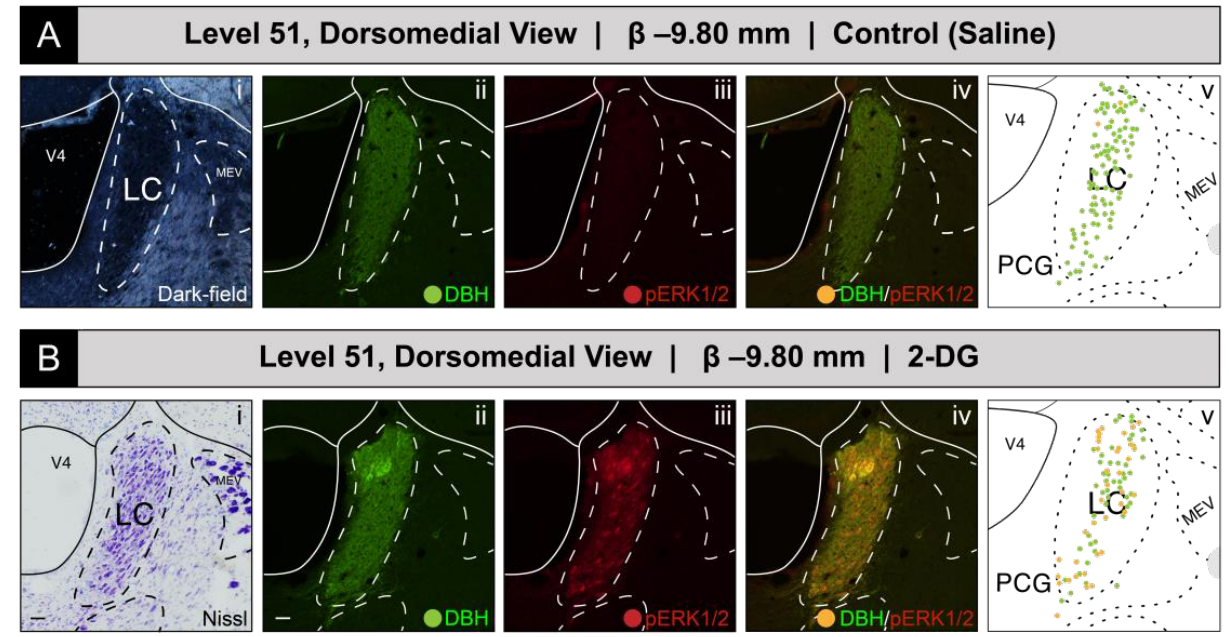
Figure 2. Increased recruitment of locus ceruleus (Wenzel and Wenzel, 1912) [82] (LC) neurons 15 min after intravenous 2-deoxy- D -glucose (2-DG) administration, as deduced from a comparison of LC perikaryon profiles in coronal-plane tissue sections from saline- ( A ) and 2-DG-treated ( B ) subjects. ( Ai – Aiv ): Subject K10-012 (saline-treated). The LC of the right hemisphere, as visible in a dark-field image ( Ai ), was immunostained for DBH ( green ; ( Aii )) and for the activation marker, phospho-ERK1/2 ( red , ( Aiii )), but displayed virtually no signal for the latter molecule. ( Bi – Biv ): Subject K10-026 (2-DG- treated). In contrast, this subject displayed a robust phosopho-ERK1/2-immunoreactive signal